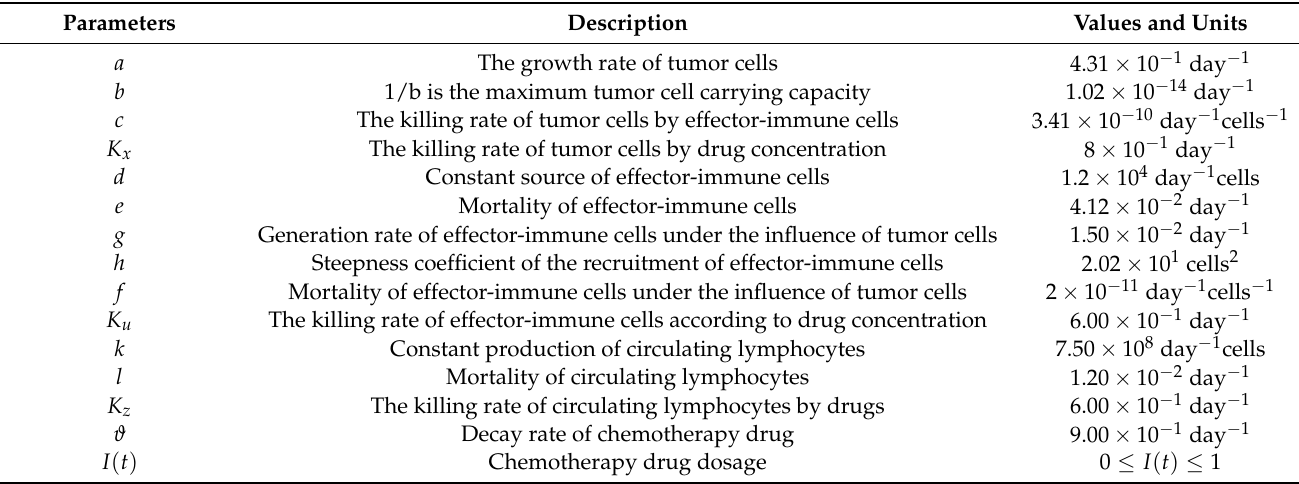
Table 1. Parameters of the mathematical equations of the